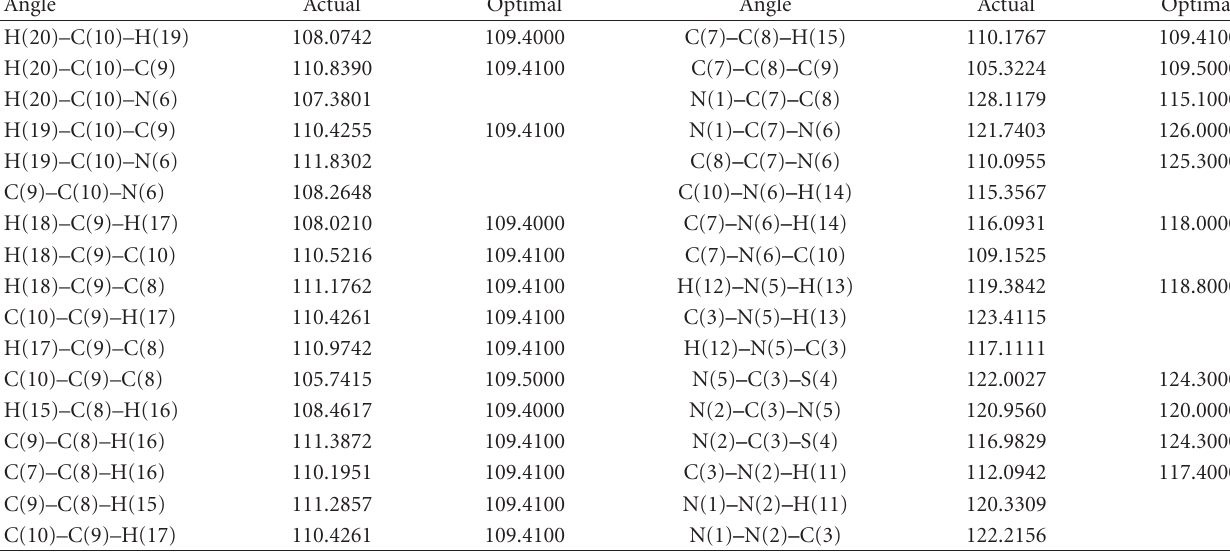
Table 4: Bond angles of the ligand.